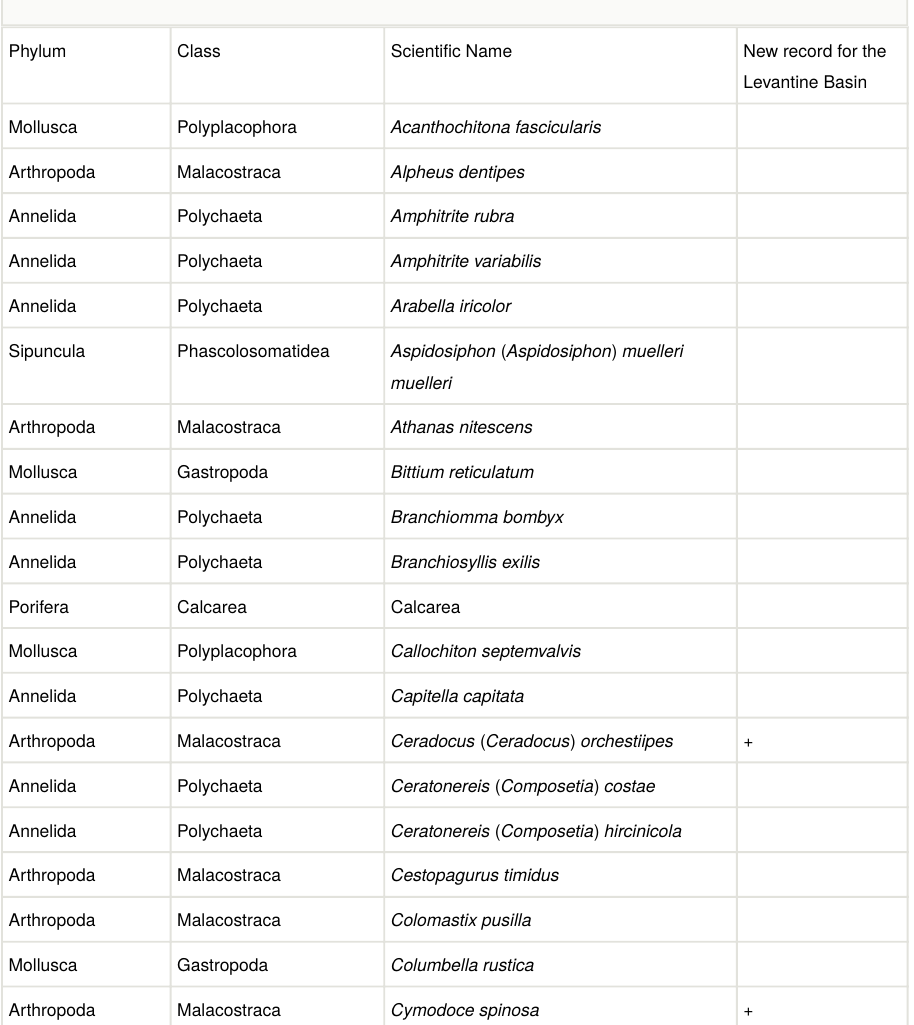
Description: The dataset comprises distribution information for 90 taxa, belonging in 48 families and 8 phyla. Detailed information is presented in Table 2. Of these, 8 species have been recorded for the fi rst time in the Levantine Basin. Table 2. Taxa identi fi ed to the lowest taxonomic level possible and included in the dataset. *: non-indigenous species (ÖZTOPRAK et al. 2014, Pancucci-Papadopoulou et al. 2005). **: identi fi cation questionable for individuals from Cyprus (may be in fact Phascolosoma ( Phascolosoma ) stephensoni ) (Açik